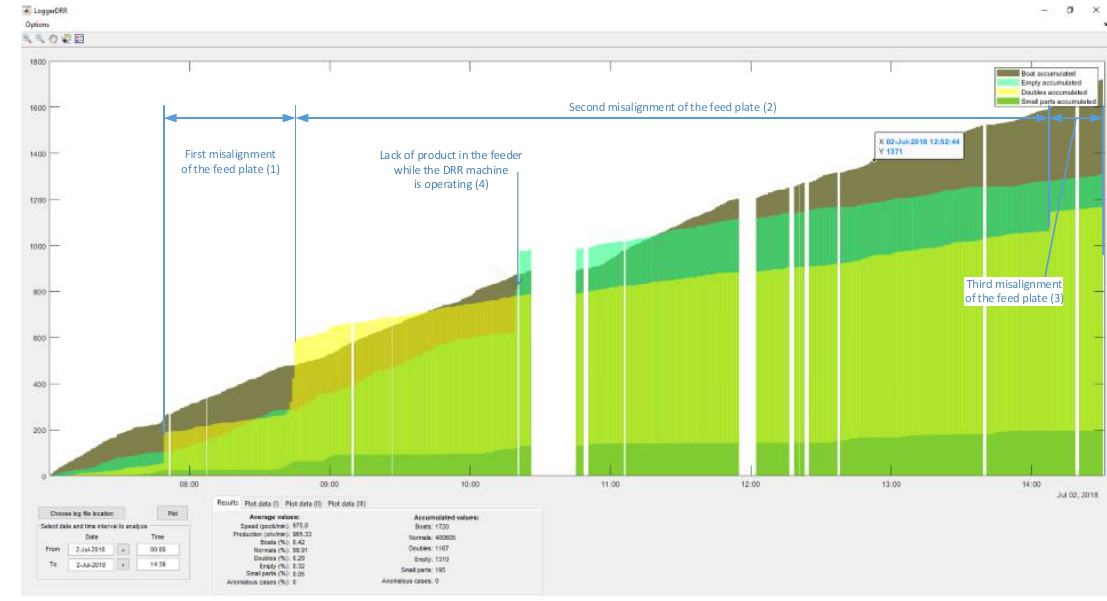
Figure 18. Multiple accumulated values (boats, empty, doubles and small parts).